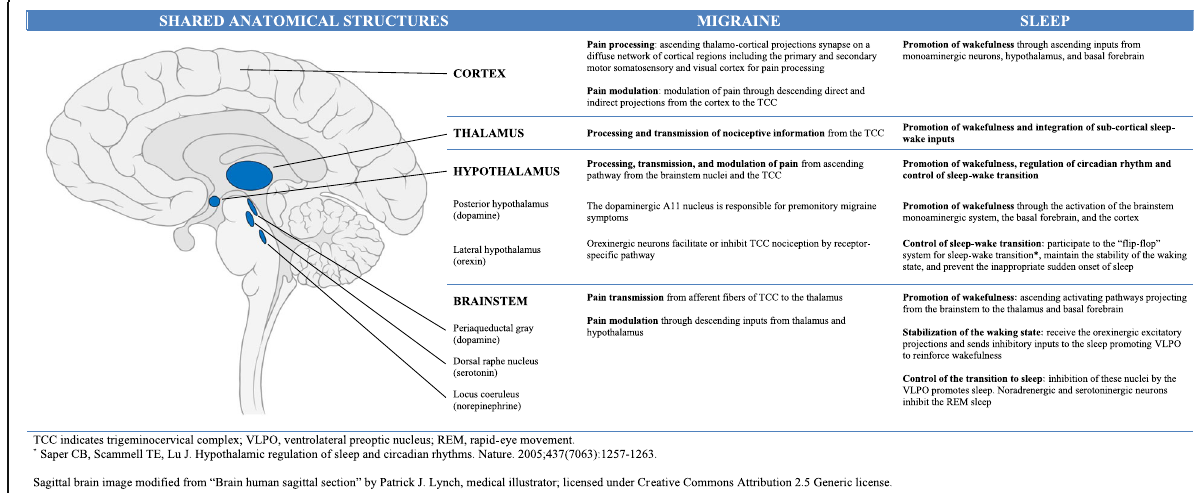
Fig. 1 Key structures involved in migraine and sleep-wake